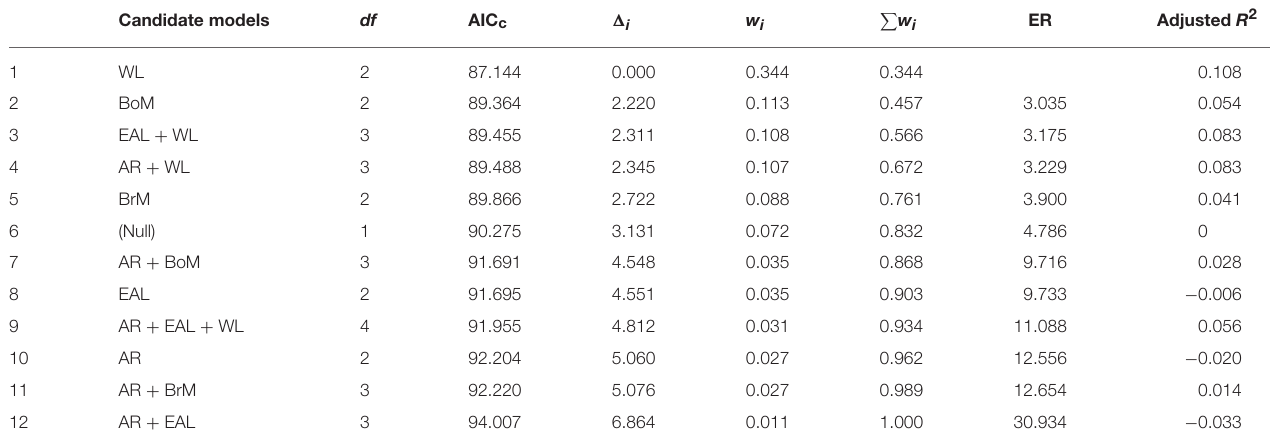
All variables were log 10 transformed. df, degrees of